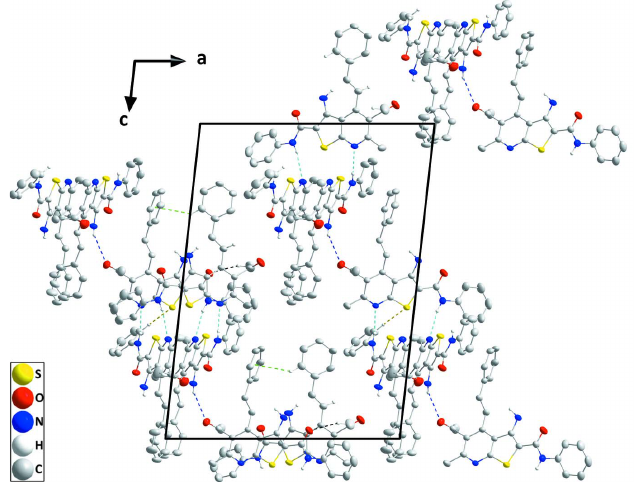
The red spots on the Hirshfeld surface are indicative of contacts shorter than van der Waals separations and represent N—H (cid:2) (cid:2) (cid:2) N, N—H (cid:2) (cid:2) (cid:2) O, C—H (cid:2) (cid:2) (cid:2) O and C—H (cid:2) (cid:2) (cid:2) S contacts. Fig. 7 displays the full two-dimensional fingerprint plot and